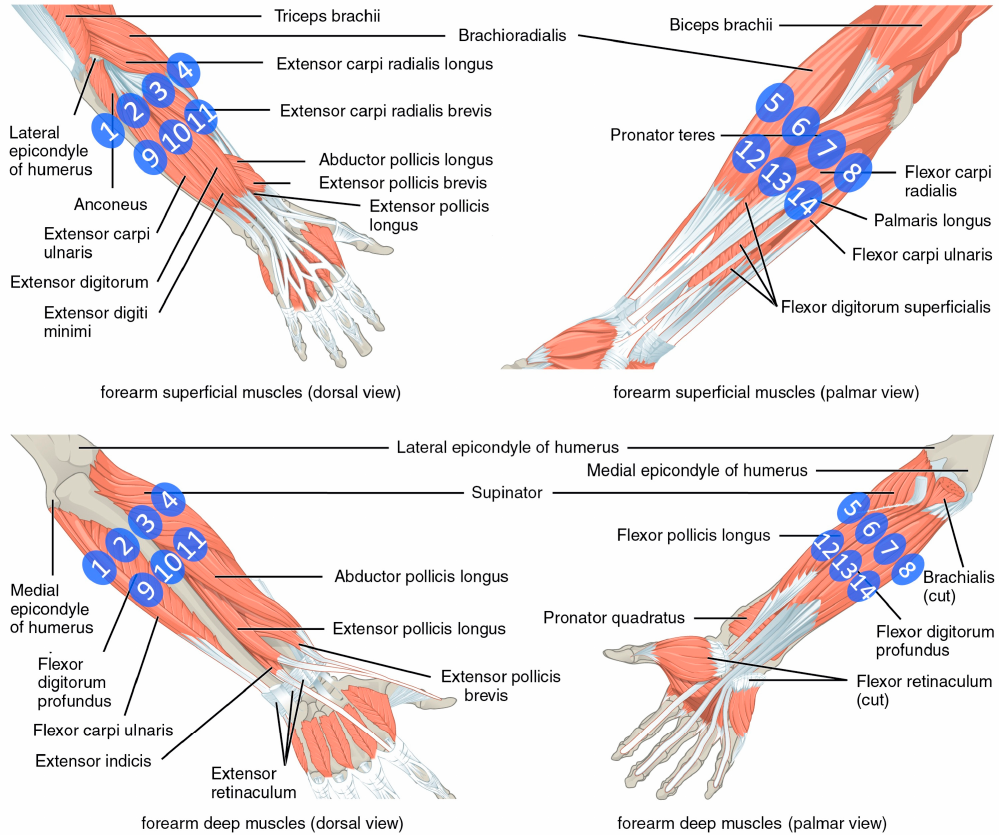
Figure 4. Positioning of the electrodes and underlying specific muscles. The image was adapted using file licensed under the Creative Commons Attribution 4.0 International license (Picture was adapted using https: // upload.wikimedia.org / wikipedia / commons / 7 / 73 / 1120_Muscles_that_Move_the_ Forearm.jpg, from the Textbook OpenStax Anatomy and Physiology (source: https: // cnx.org / contents